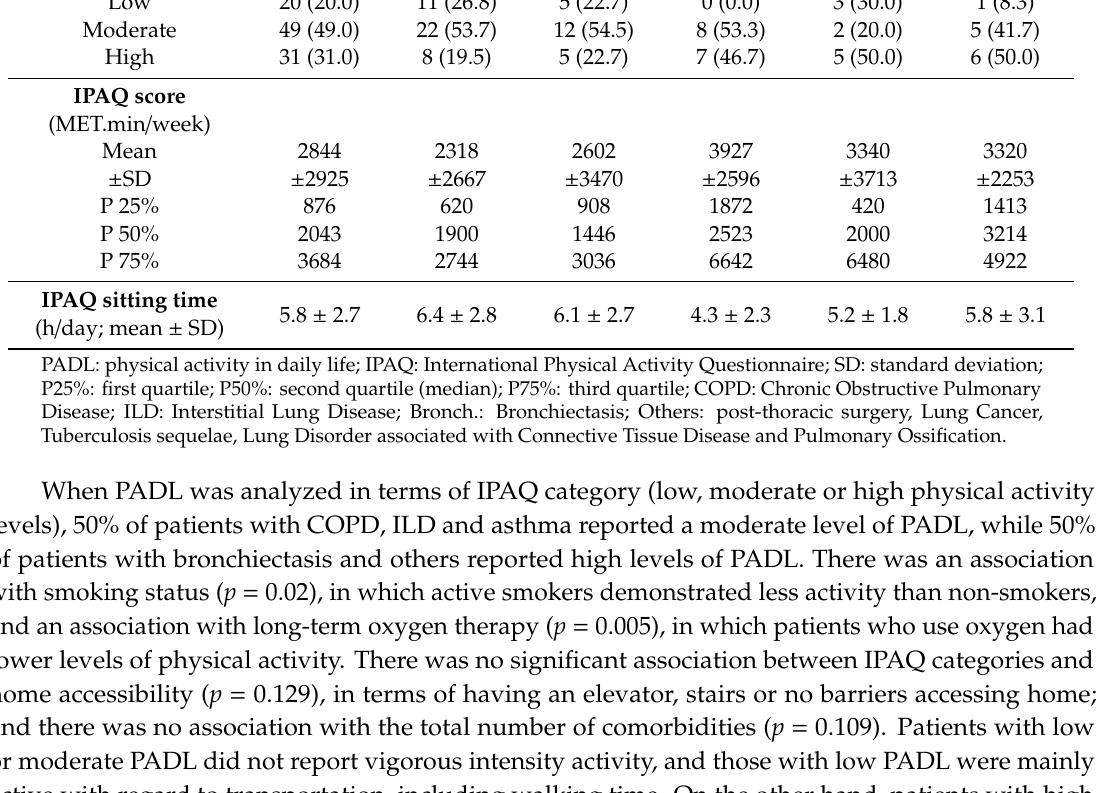
Table 2. Subjective International Physical Activity Questionnaire (IPAQ) physical activity in daily life (PADL) assessment per chronic respiratory disease. Total COPD ILD Asthma Bronch. Others n =